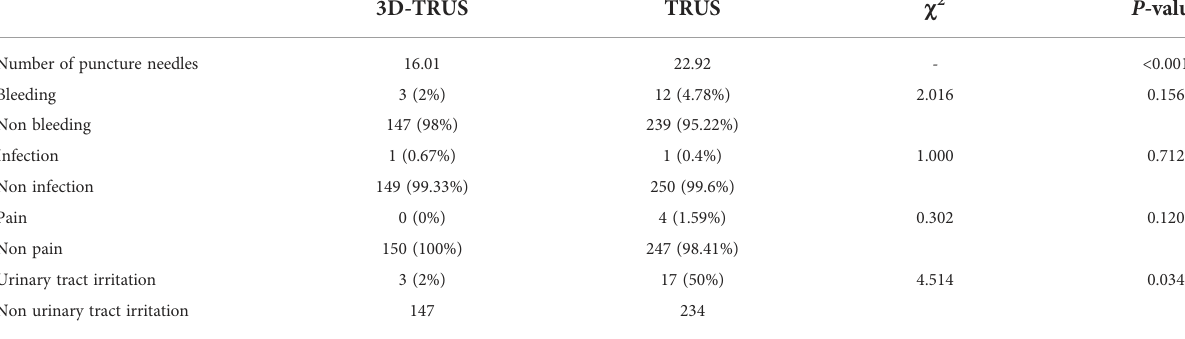
TABLE 10 Comparison of complications after biopsy session between 3D-TRUS and TRUS.